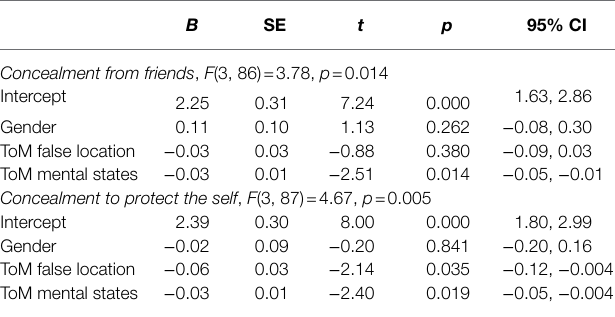
TABLE 2 | Model information for concealment and disclosure outcomes. B